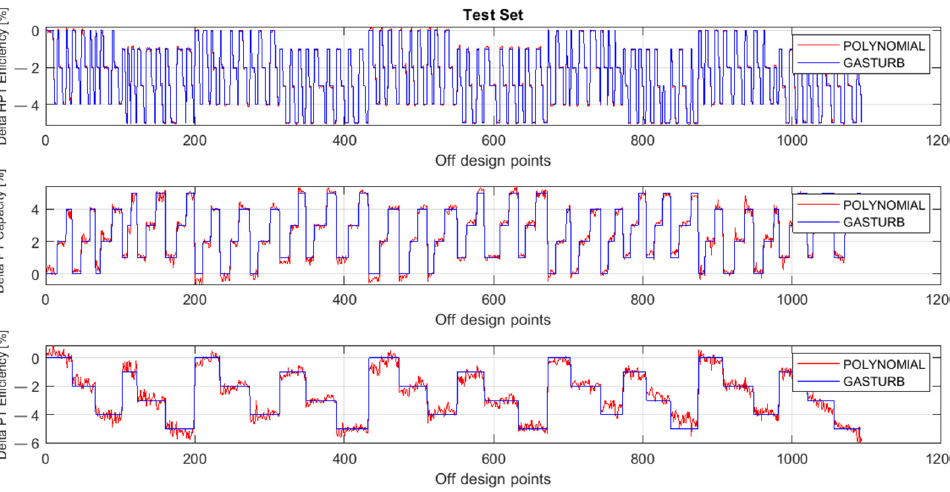
Figure 3. Fault parameters ∆ HPTE, ∆ PTC, and ∆ PTE, true and simulated by polynomials (validation set).